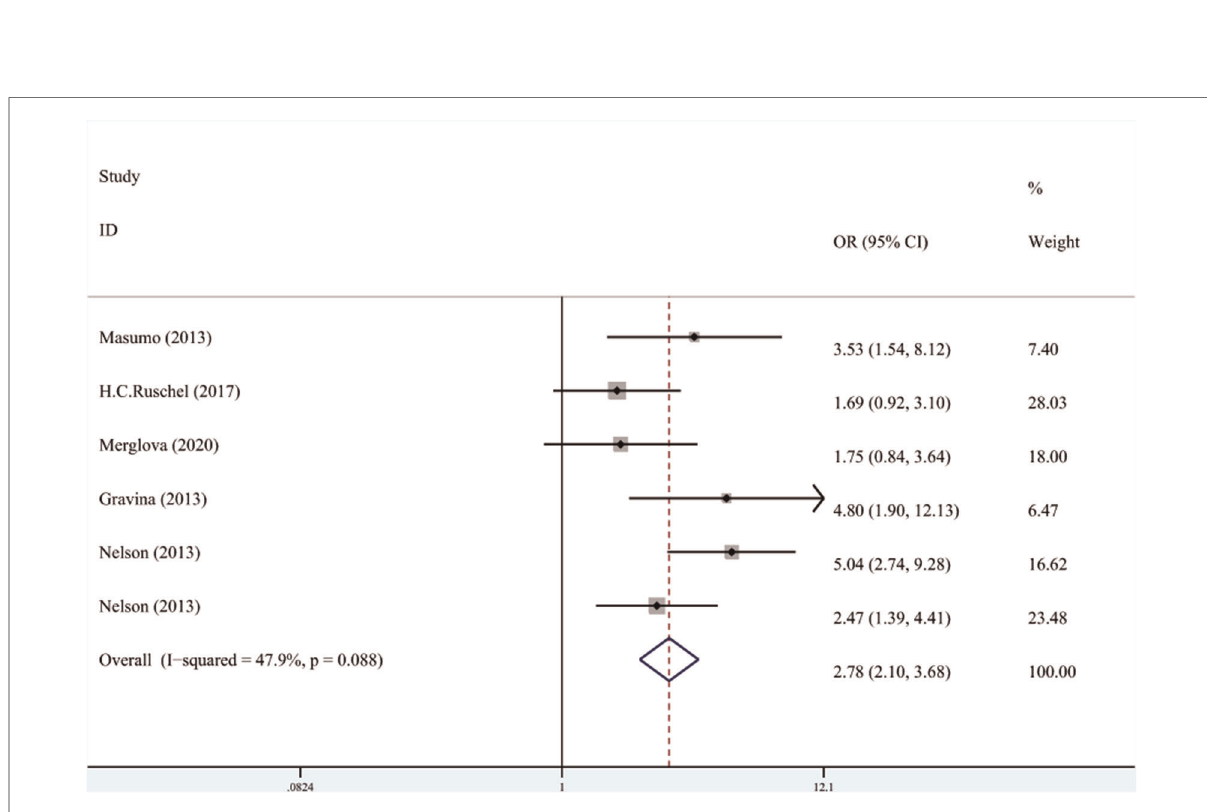
FIGURE 7 The forest plot shows the relationship between LBW and EHP (FEM). LBW, low birth weight; EHP, enamel